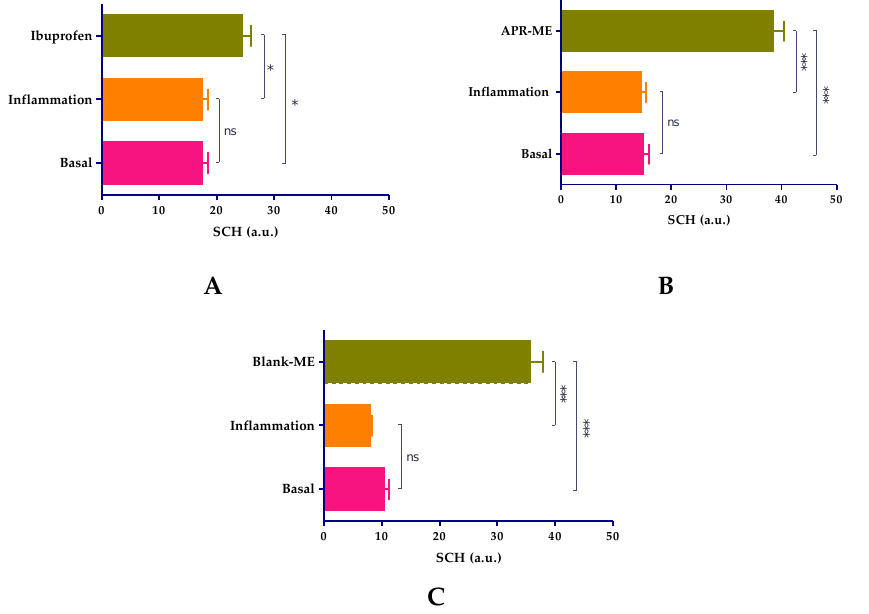
Figure 10. Evaluation of stratum corneum hydration (SCH). ( A ) Ibuprofen treatment group;